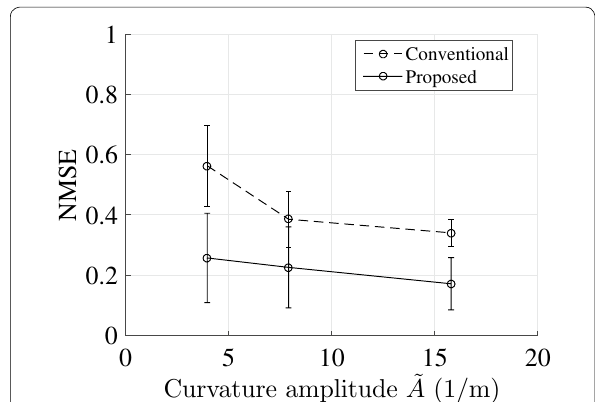
Fig. 8 Graph showing the relationship between the curvature amplitude ˜ A and the NMSE